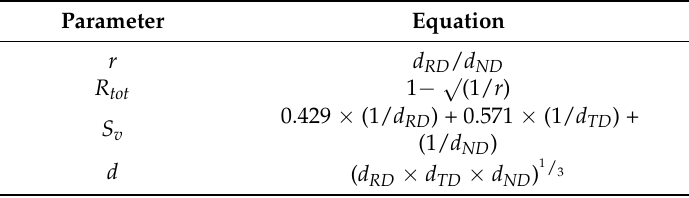
Table 3. Austenite grain structure parameters